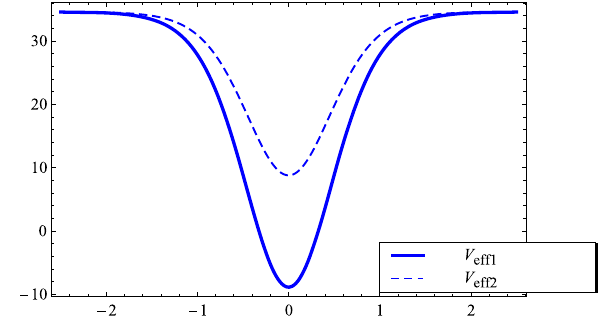
Fig. 1 The effective potentials V eff1 and V eff2 with v = 1 , a = 1 , τ =